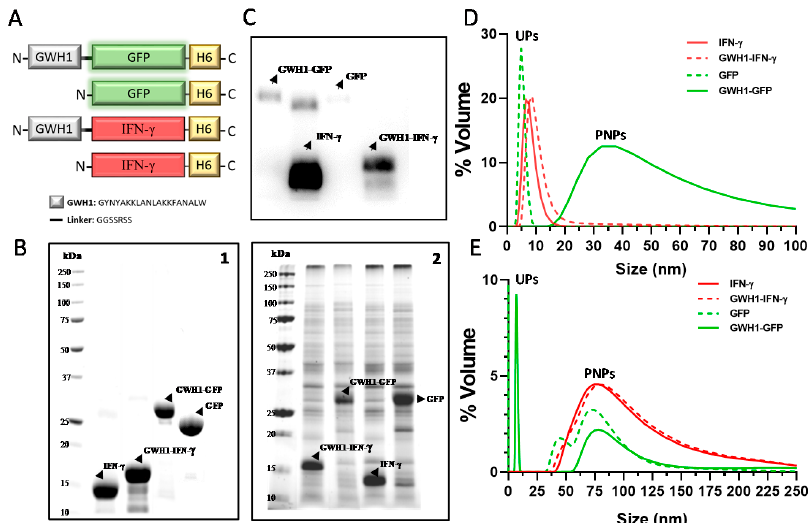
Figure 1. Characterization of the di ff erent protein formats employed in this study. ( A ) Schematic representation of multimeric fusion proteins. The presence of a cationic peptide (GWH1) in the N-terminus, plus the His6 tag in C-terminus, may induce the formation of protein-only nanoparticles (PNPs). A linker between GWH1 and the sca ff old protein was added in order to increase flexibility and facilitate self-assembling process. ( B ) TGX Stain-free TM analysis showing the purity of the di ff erent protein designs in both, soluble proteins ( B1 ) and IBs ( B2 ). ( C ) Western blot showing the qualitative amount of protein released from the di ff erent IBs. ( D ) Evaluation of self-assembling capabilities of purified soluble proteins by size determination using DLS. PNPs: protein nanoparticles; UPs: unassembled proteins. ( E ) Size distribution of the protein samples obtained after solubilization from di ff erent IBs analyzed by DLS.